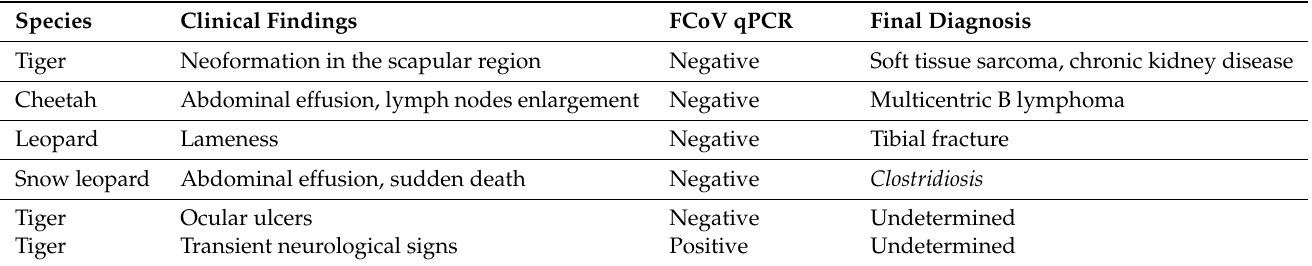
Table 5. Clinical features, final diagnosis, and FCoV status of unhealthy